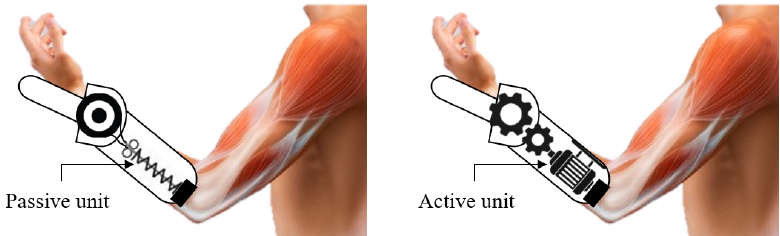
Figure 19. Classification criteria based on the type of actuation: passive or